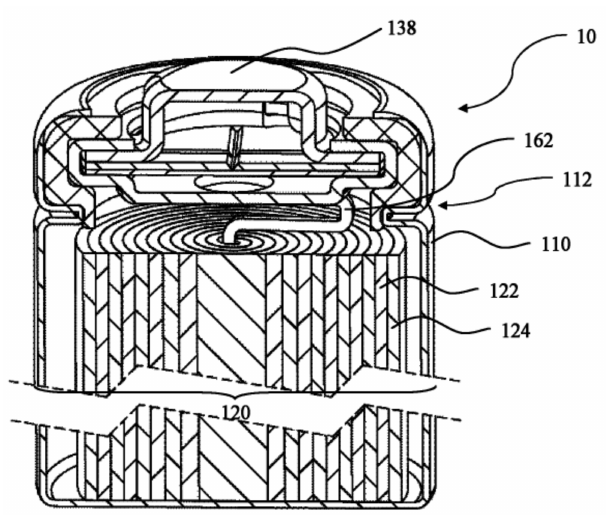
Figure 5. Schematic diagram of a new venting cap design with 10: battery, 138: vent cap, 162: conductive lead, 112: groove, 110: cell can, 122: positive electrode, 124: negative electrode, and 120: electrode assembly [19].